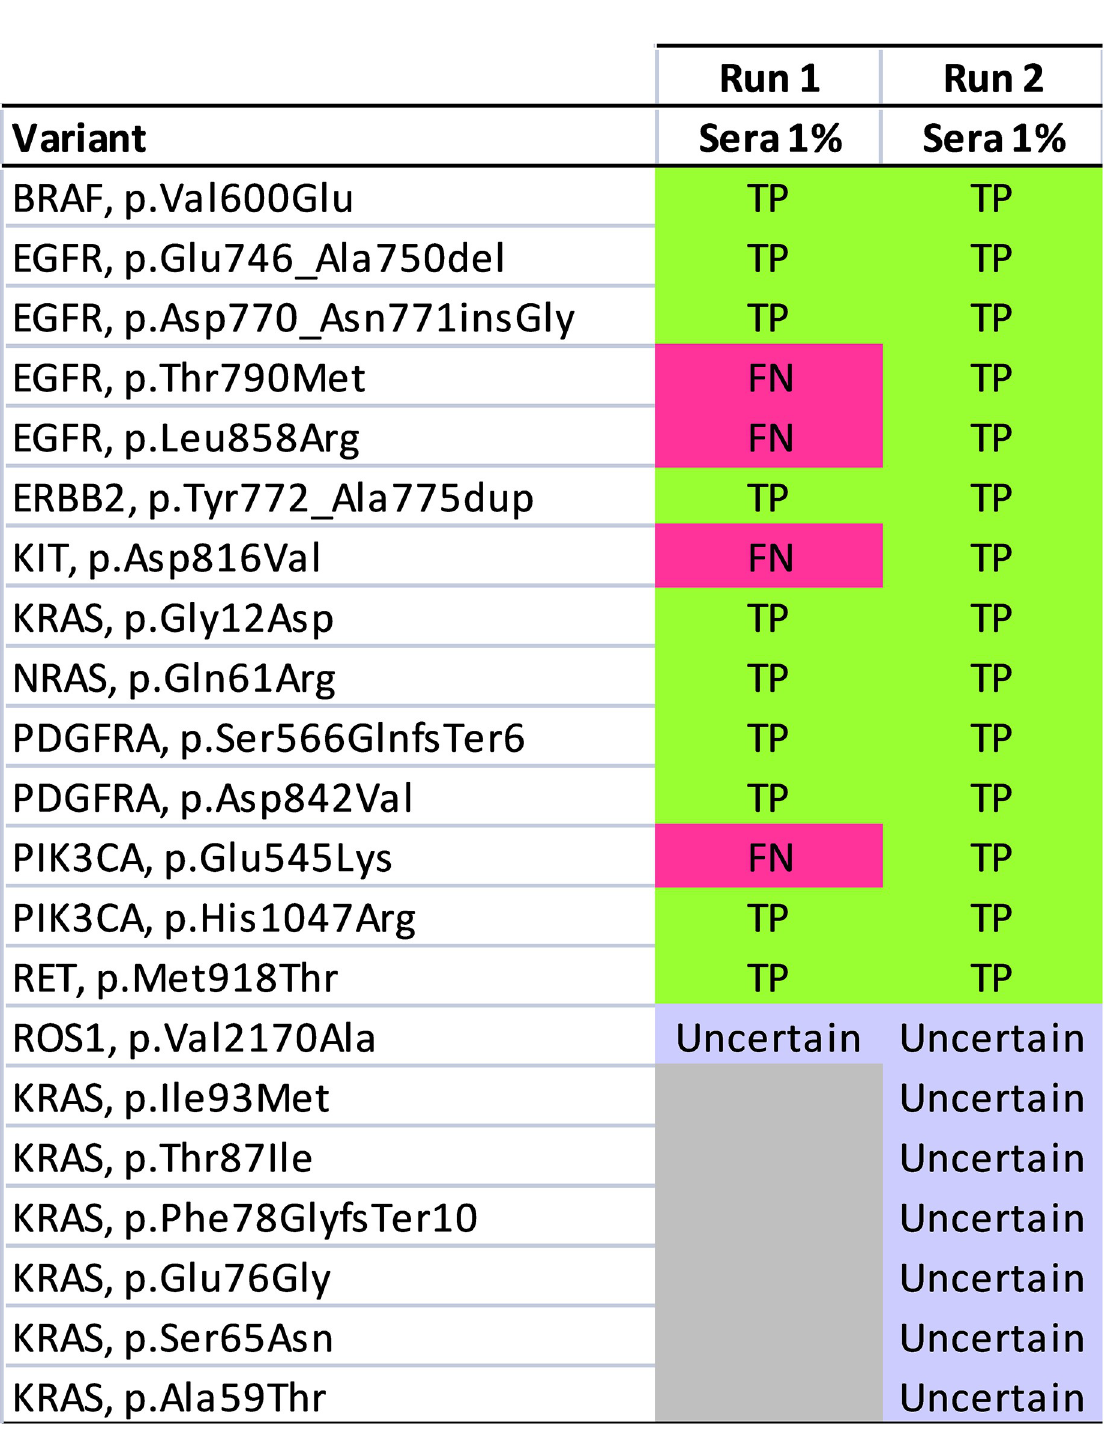
PLOS ONE | https://doi.org/10.1371/journal.pone.0276161 October 18,